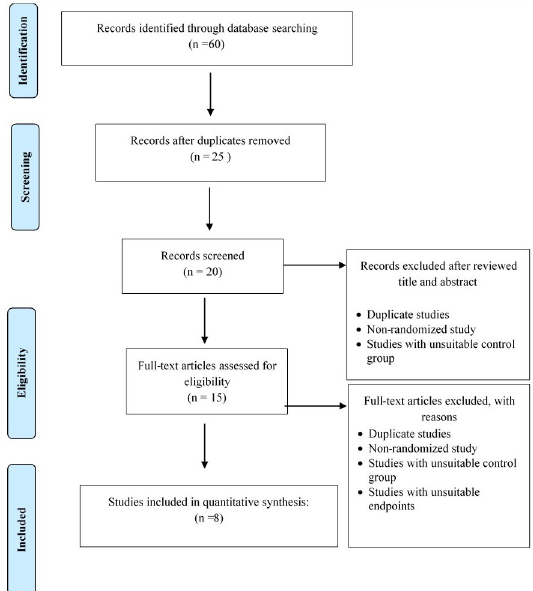
Fig 12. PRISMA flow diagram of literature search for optimal dose of disaster preparedness intervention utilising health belief model theory.